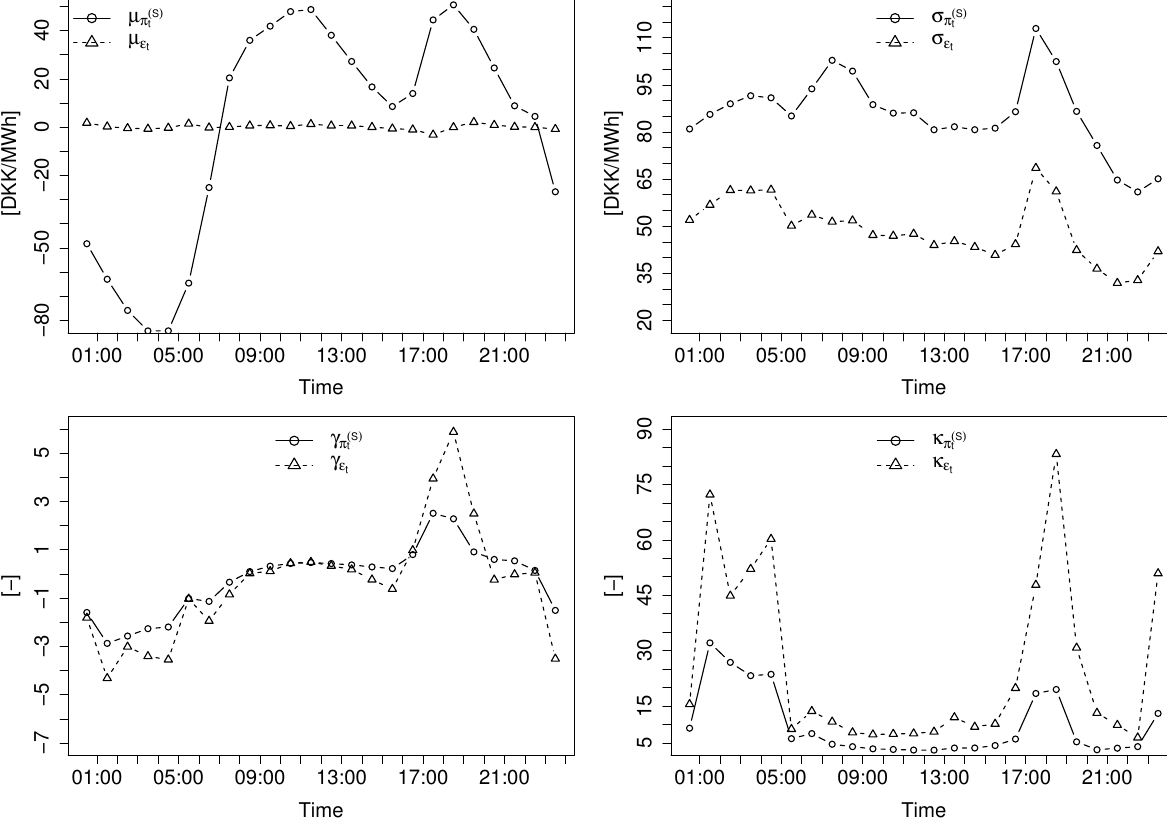
Figure 4. Hourly centered moments of ε